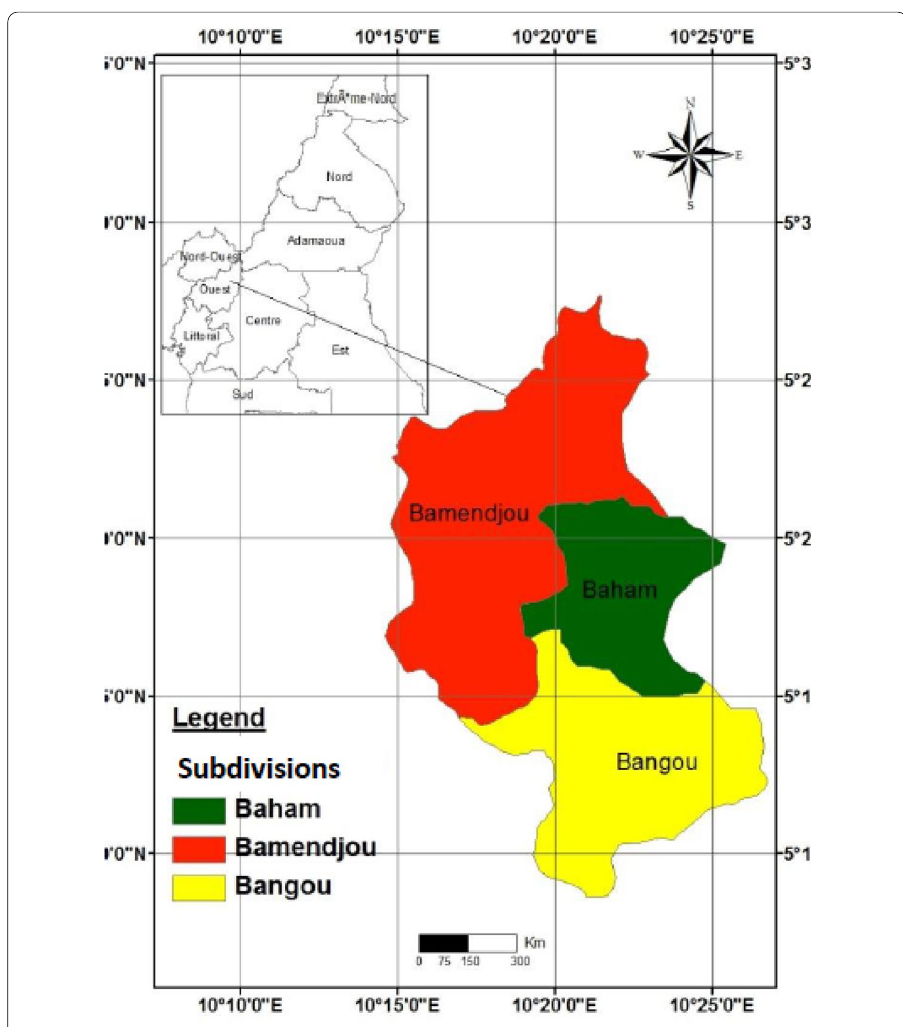
Fig. 1 Localization of Bamendjou on the Cameroon